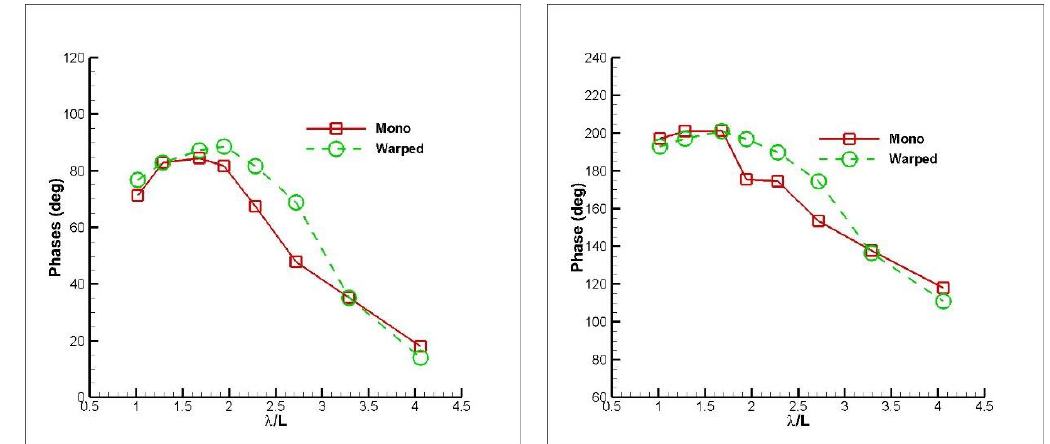
Figure 13. Phases of heave ( left ) and pitch ( right ) for both models at Fn B = 2.26.